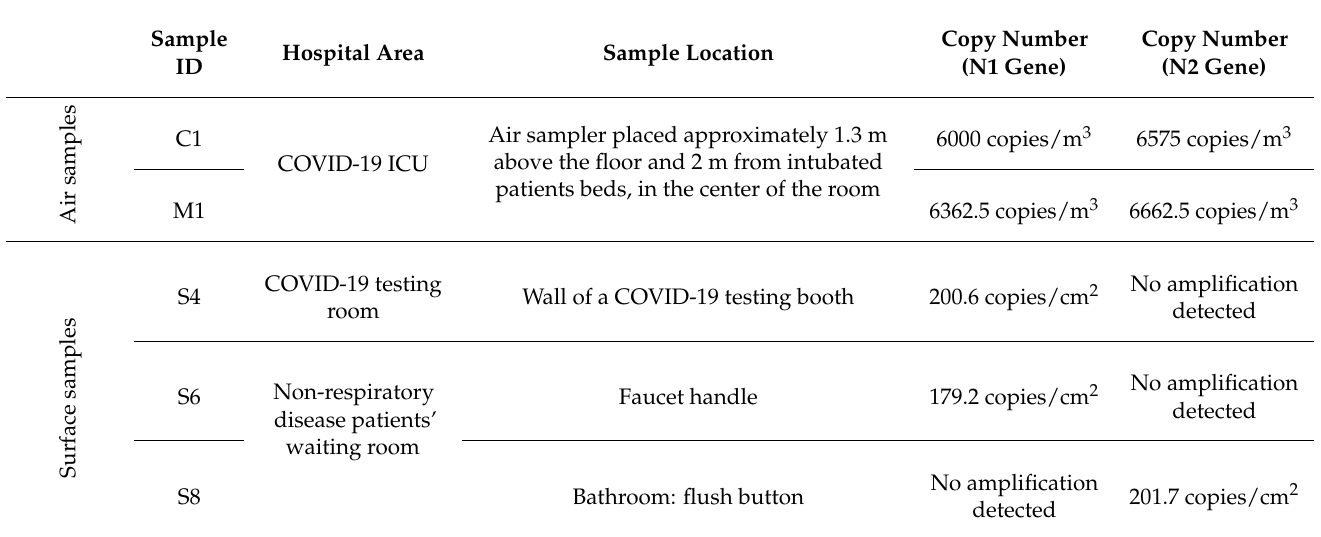
Table 4. Details of Hospital area, sampling location and viral genome copy numbers of the positive air and surface